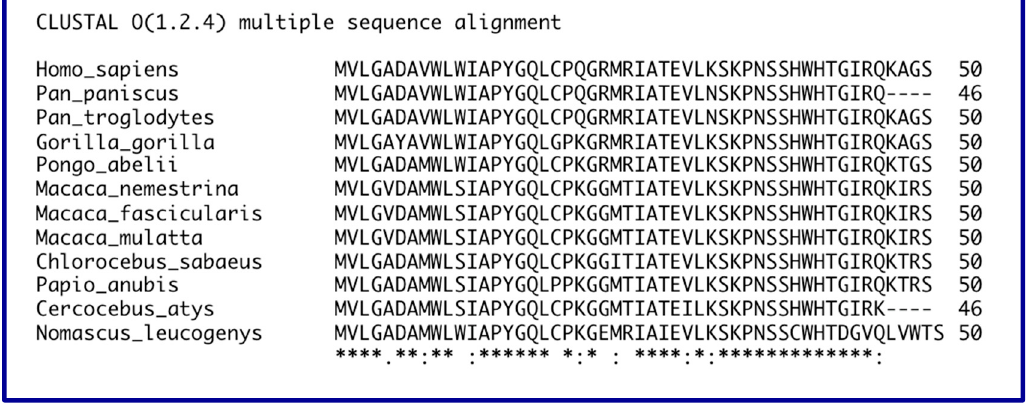
Figure 5. Clustal alignment of the conceptual translation of the small ORF in man and eleven non-